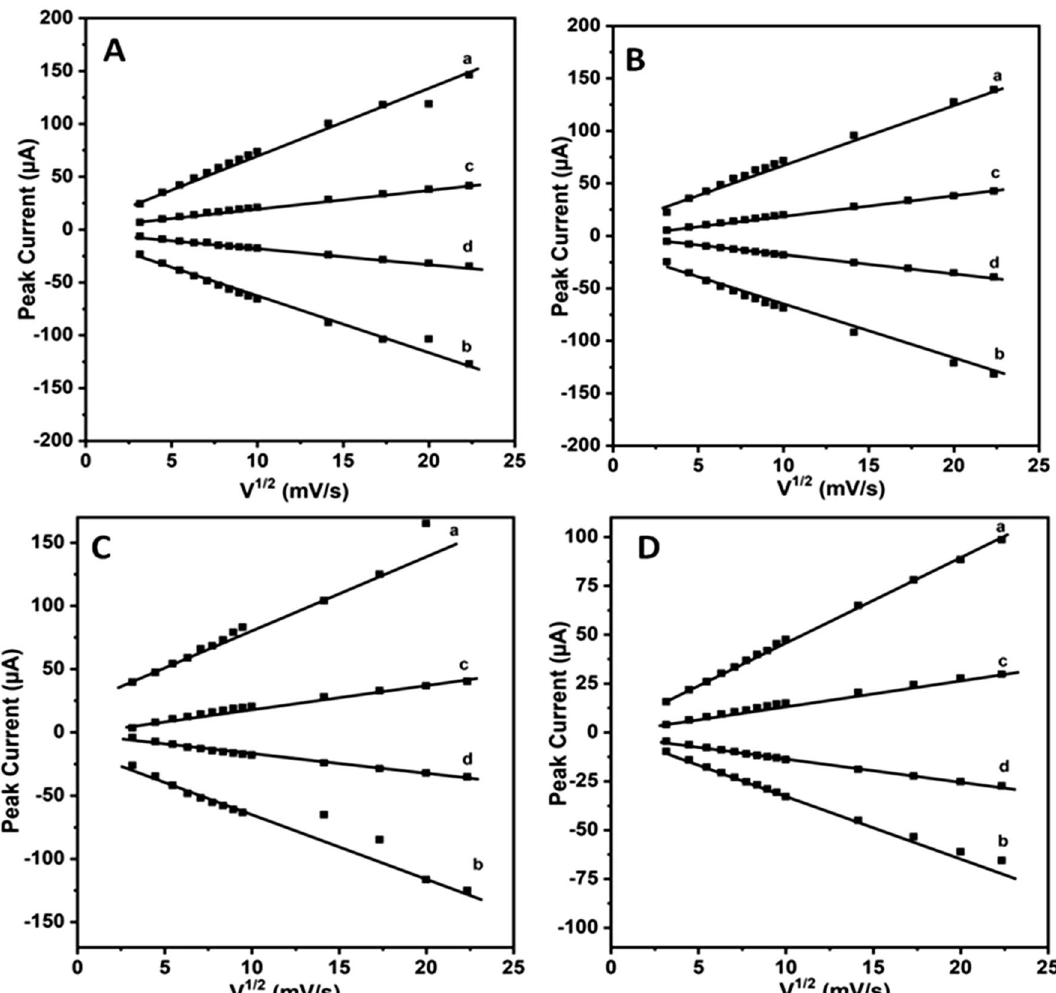
Figure 5. Plots of peak current vs. square root of scan rate obtained using Au ( A , C ) and Pt ( B , D ) electrodes for various bio-mimic systems studied in this work namely ( A ) Sweat, ( B ) Saliva, ( C ) Sweat + Triton X-100 and ( D ) Saliva + Triton X-100 respectively. These data points were collected from Figs. 4 and S2. In these plots (a) & (c) represent I